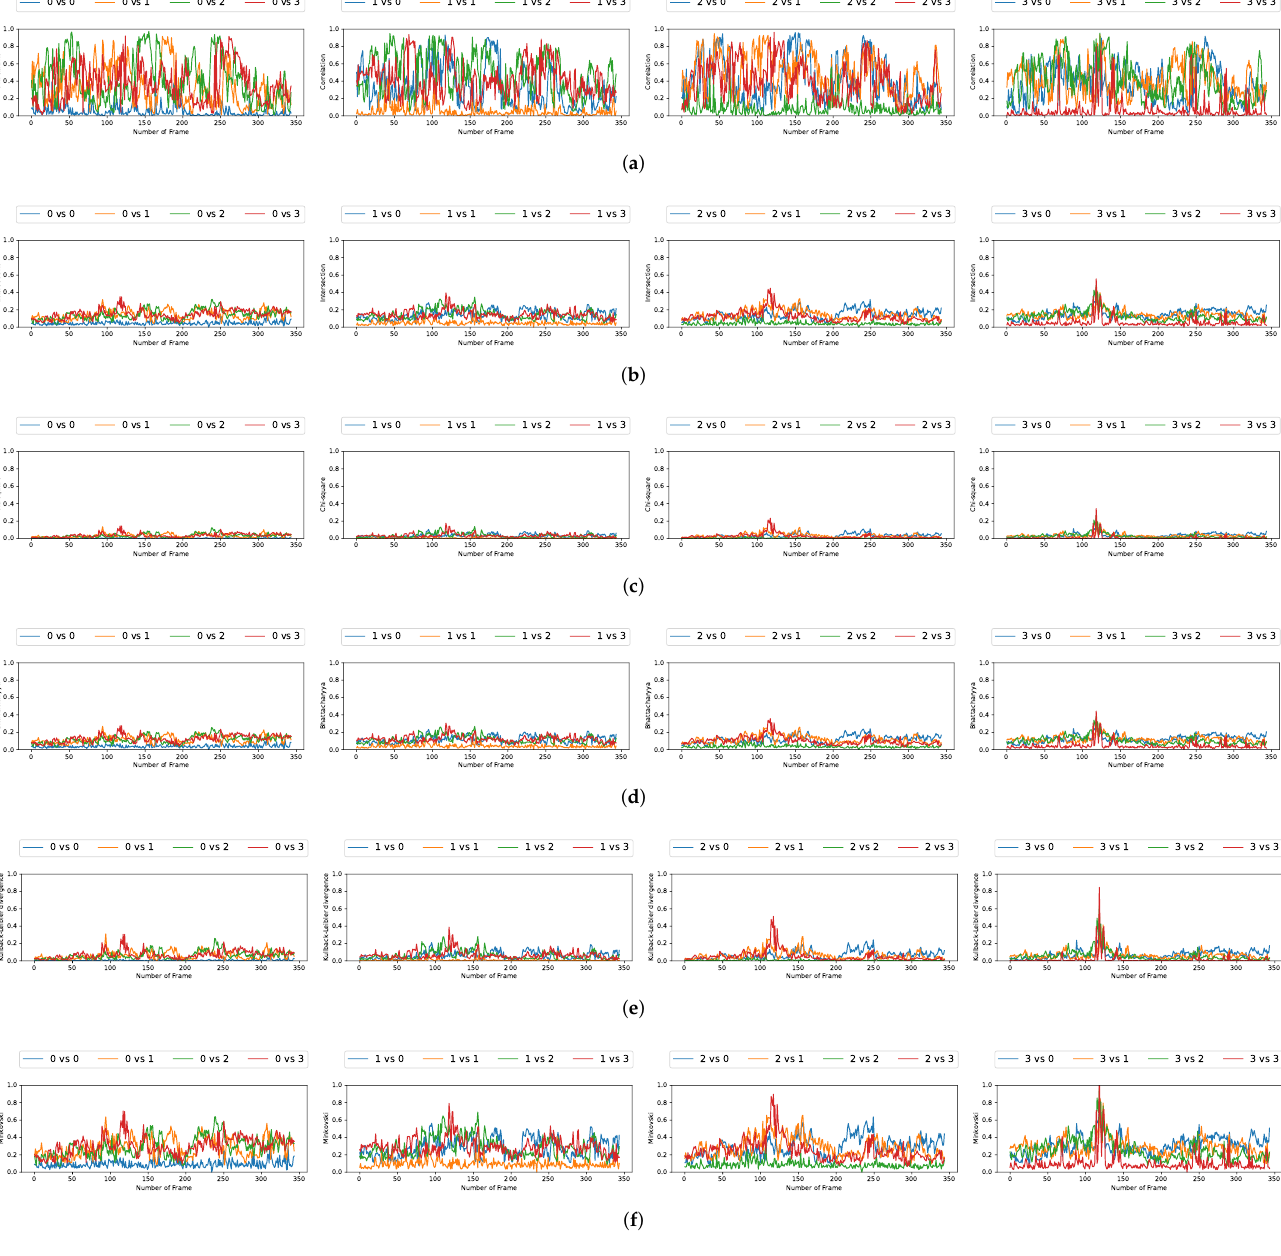
Figure 8. Curves comparing persons from one frame to another in video 1 (persons 0, 1, 2, and 3) using the HOG. ( a ) Correlation. ( b ) Intersection. ( c ) Chi-square. ( d ) Bhattacharyya. ( e ) KL divergence. ( f )